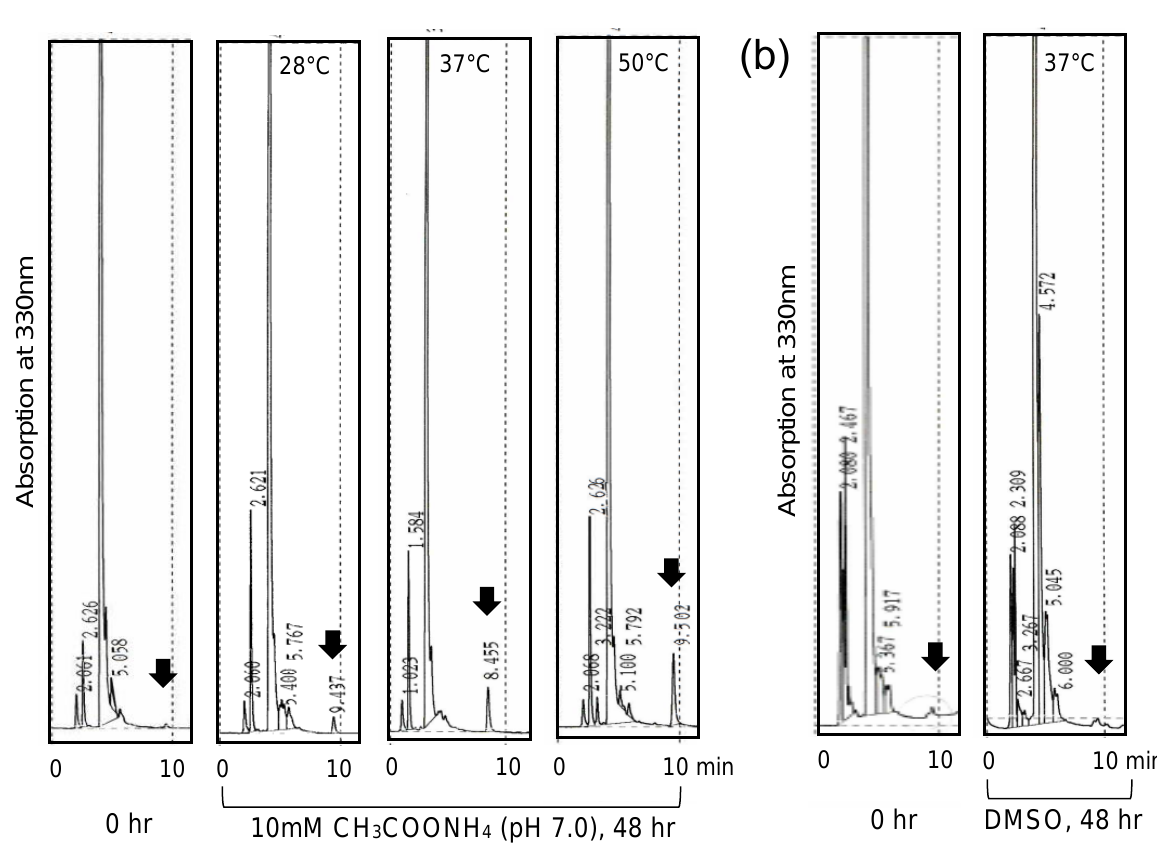
Figure 9. Stability of the CTN-KA adduct: ( a ) CTN-KA adduct was incubated in 10 mM ammonium acetate buffer (pH 7.0) at 28 °C, 37 °C, or 50 °C for 48 h. The resulting metabolites were analyzed by HPLC using ODS columns and the solvent acetonitrile/water/TFA (450:550:0.5, v / v / v ) at 1 mL min − 1 . The peaks of CTN (black thick arrows) increased with the temperature in this aqueous solution; ( b ) CTN-KA adduct was incubated in DMSO at 37 °C for 48 h, CTN did not increase, suggesting that the CTN-KA adduct was stable in DMSO.